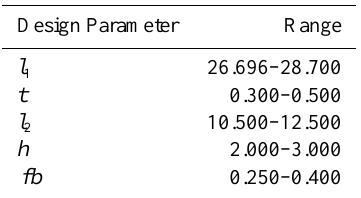
Table 5 design parameters l 1 , l 2 , and h have the most e ff ect